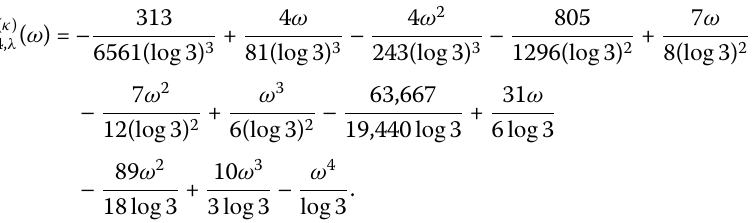
Figure 1 Graphs of β ( κ ) υ